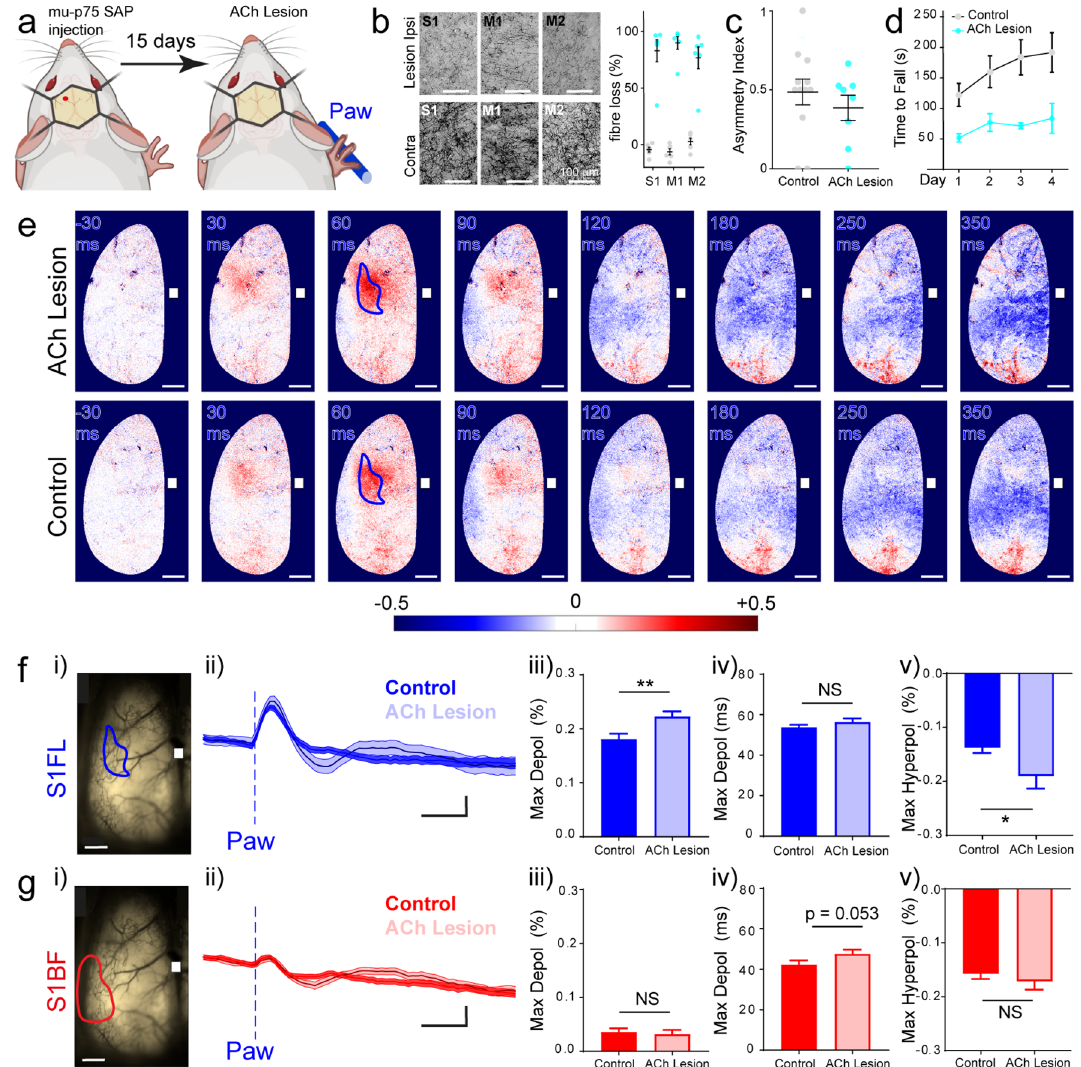
Figure 4. Specific lesion of cortical cholinergic fibres re-shapes the amplitude and timing of tactile-evoked voltage responses in sensory cortical areas. (“Results”; “Discussion”). ( a ) Schematic methods. Mice received a unilateral cortical injection of mu-p75 SAP or rabbit IgG SAP Control into the left hemisphere, red dot indicates injection site. 15 days later mice were head-fixed and imaged during paw stimulation. Mouse images created with Biorender.com. ( b ) Reduction of cholinergic fibres in the contralateral cortex (visualised with acetylcholinesterase staining 15 days after mu-p75SAP injection). Percentage of cholinergic fibre loss relative to the contralateral (non-injected hemisphere). Two-way ANOVA, Areas F (2, 30) = 0.08495, p = 0.9188, Groups F (1, 30) = 276.4, p < 0.0001; Interaction F (2, 30) = 1.586, p = 0.2214. Data are mean ± SEM. (Cholinergic (ACh) lesion n = 6 mice, control n = 6 mice). ( c ) The forelimb asymmetry index is unaffected 15 days after ACh lesion. Wilcoxon Signed Rank Test, compared to 0.5, theoretical value of symmetrical use of the forelimbs, p ≥ 0.05 ACh lesion p = 0.2812, Control p = 0.9297; and unpaired t-test, t (18) = 0.8387, p = 0.4126 (ACh lesion n = 12, control n = 8). ( d ) ACh-lesioned mice show impaired performance on the accelerating rotarod 15 days after the lesion, compared with time- matched Control mice (Two-way repeated measurements ANOVA, Interaction F (3, 27) = 1.484, p = 0.2411; time F (3, 27) = 7.071, p = 0.0086; groups F (1, 9) = 6.993, p = 0.0267 (ACh lesion n = 4, control n = 7). ( e ) Sensory-evoked voltage maps in response to paw stimulation at selected times before and after stimulation (0 ms) in ACh-lesioned and Control mice. Scale bar is 1 mm. Bregma shown with a white square. Depolarised pixels red, + 0.5% ΔR/R and hyperpolarised pixels blue, − 0.5% ΔR/R. Maps contain the same data as the traces in F and G. (ACh lesion n = 58 trials, 6 mice. Control n = 61 trials, 6 mice, all 15 days after injection). Side by side videos of responses to forepaw stimulation in mice 15 days after mu-p75SAP injection and control can be found in Supplementary Video 3. ( f ) (i) Through-skull cranial window with mapped areas according to “The Mouse Brain in Stereotaxic Coordinates” 48 , relative to bregma. (S1FL Forelimb area of the primary sensory cortex). Bregma shown with a white square. (ii) Average voltage traces from the S1FL area in response to Paw stimulation from Control or ACh-lesioned mice. Vertical dashed line represents stimulus onset. (iii) Maximum depolarisation amplitude, Unpaired t-test, t (117) = 2.706, p = 0.0078. (iv) Time of maximum depolarization, Mann–Whitney test, U = 1669, p = 0.5754. (v) Maximum hyperpolarisation amplitude, Unpaired t-test, t (117) = 2.122, p = 0.0360. ( g ) (i) Through-skull cranial window with mapped areas according to “The Mouse Brain in Stereotaxic Coordinates” 48 , relative to bregma. (S1BF Barrel field of the sensory cortex). Bregma shown with a white square. (ii) Average voltage traces from the S1BF area in response to paw stimulation from Control or ACh-lesioned mice. Vertical dashed line indicates stimulation onset. (iii) Maximum depolarisation amplitude, Unpaired t-test, t (117) = 0.4137, p = 0.6799. (iv) Time of maximum depolarization, Mann–Whitney test, U = 1411, p = 0.0528. (v) Maximum hyperpolarisation amplitude, Mann–Whitney test, U = 1624, p = 0.4430. All data are mean ± SEM. * p < 0.05, ** p < 0.01, *** p < 0.001. NS non-significant. Scale bars 0.1% ΔR/R and 100